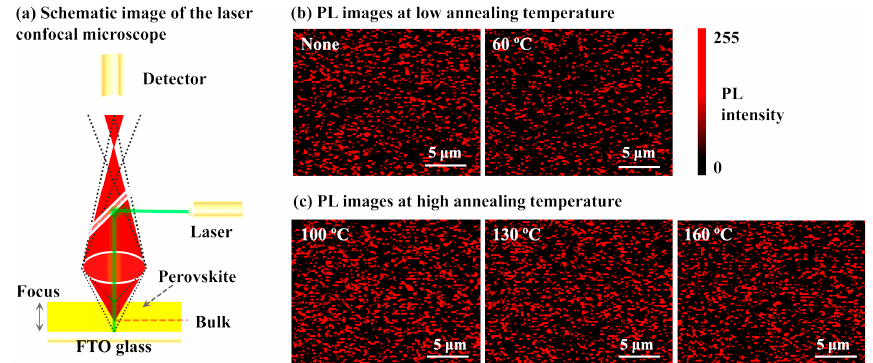
Figure 13. ( a ) Schematic image of the laser confocal microscopy and ( b , c ) the measured spatial PL images from the perovskite films annealed at low and high temperatures, respectively [117]. Copyright © 2015, American Chemical